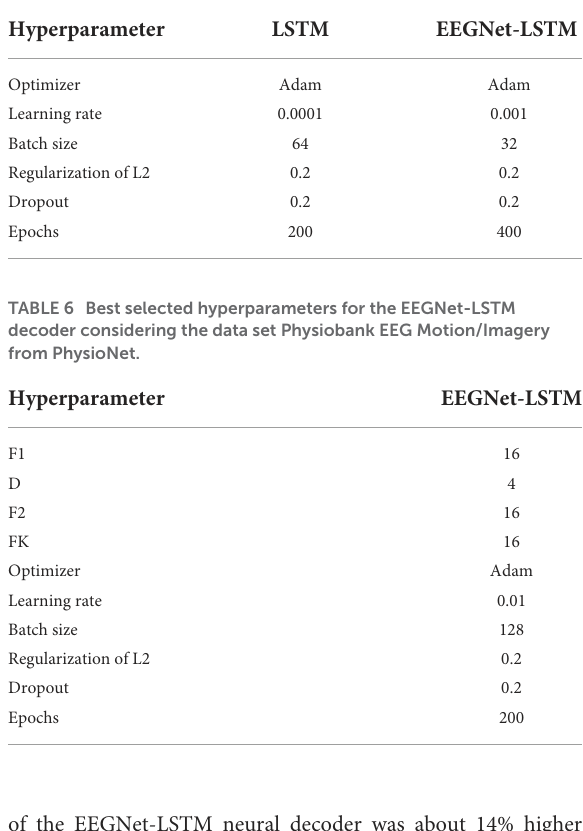
TABLE 5 Best selected hyperparameters for the decoders considering the data set 2a from BCI Competition IV.